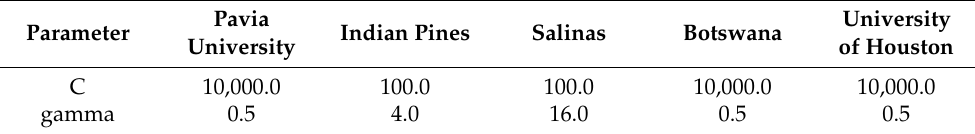
Table 2. The table illustrates the SVM parameter settings for each dataset.